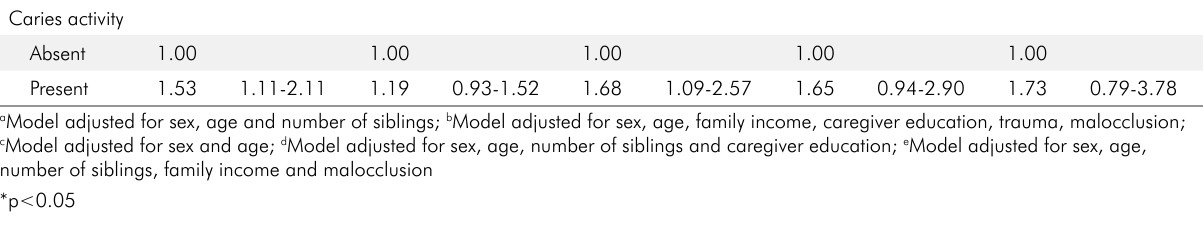
Table 4. Adjusted Poisson Regression models with robust variance of the association between caries activity according to the International Caries Detection and Assessment System (ICDAS) simplified in relation to oral health-related quality of life (OHRQOL), total score and by domains (oral symptoms, functional limitation, emotional well-being and social well-being). Pelotas, RS, Brazil (n = 119). Variable